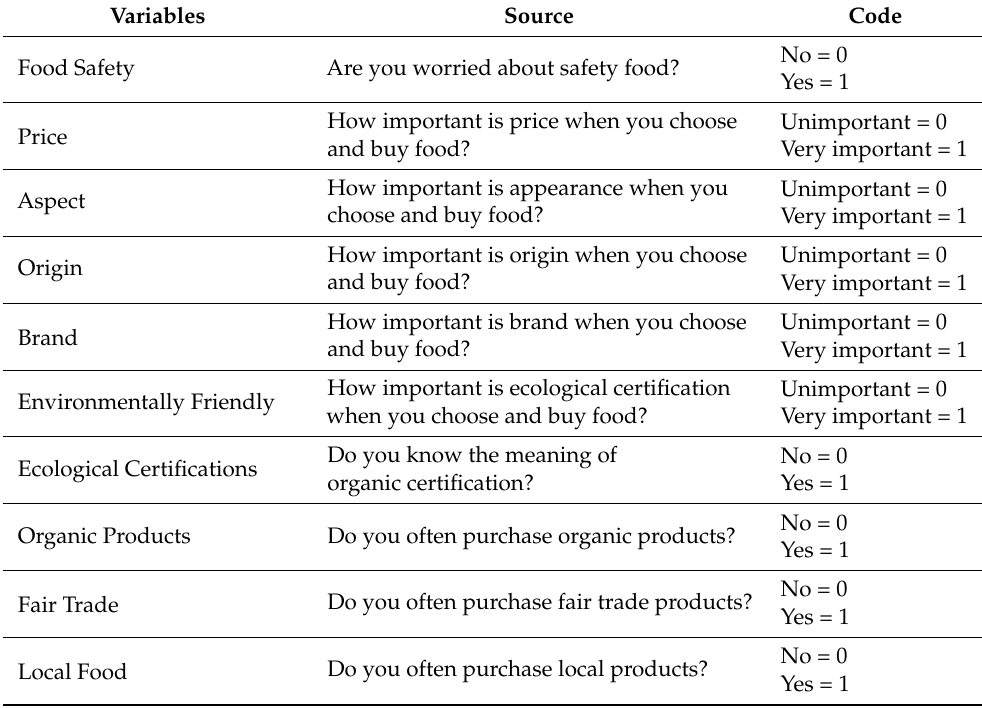
Table 1. Variables’